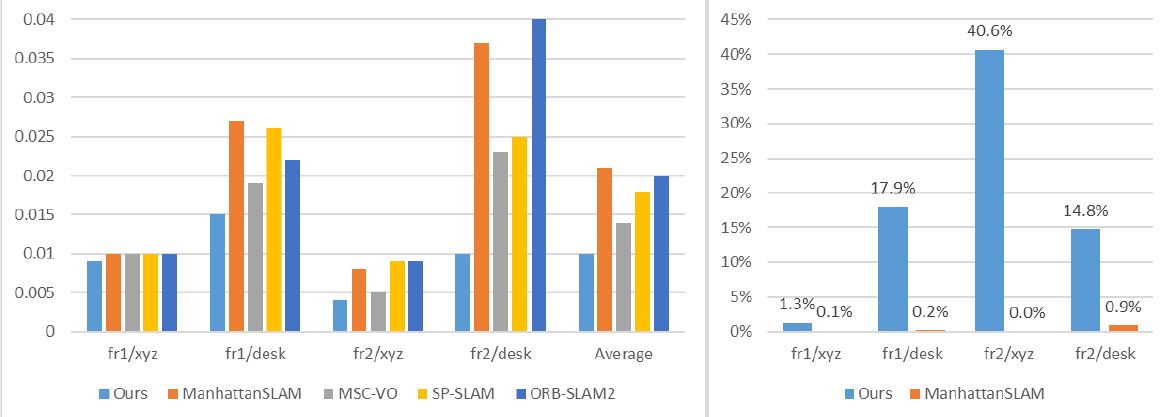
Figure 9. Left : Comparison of ATE RMSE (M) for sequence fr1/xyz, fr1/desk, fr2/xyz, fr2/desk. Right : The percentage of MFs detected from each sequence.